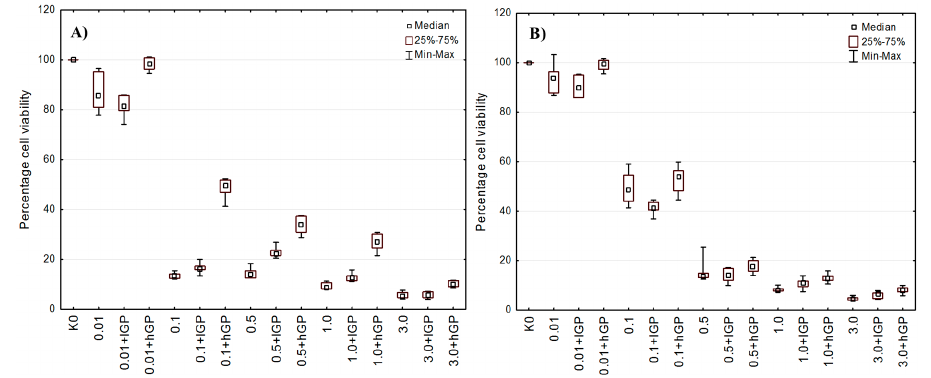
Figure 8. Box-plot graphs presenting the viability of CRL 2616 cells incubated for 4 h with different